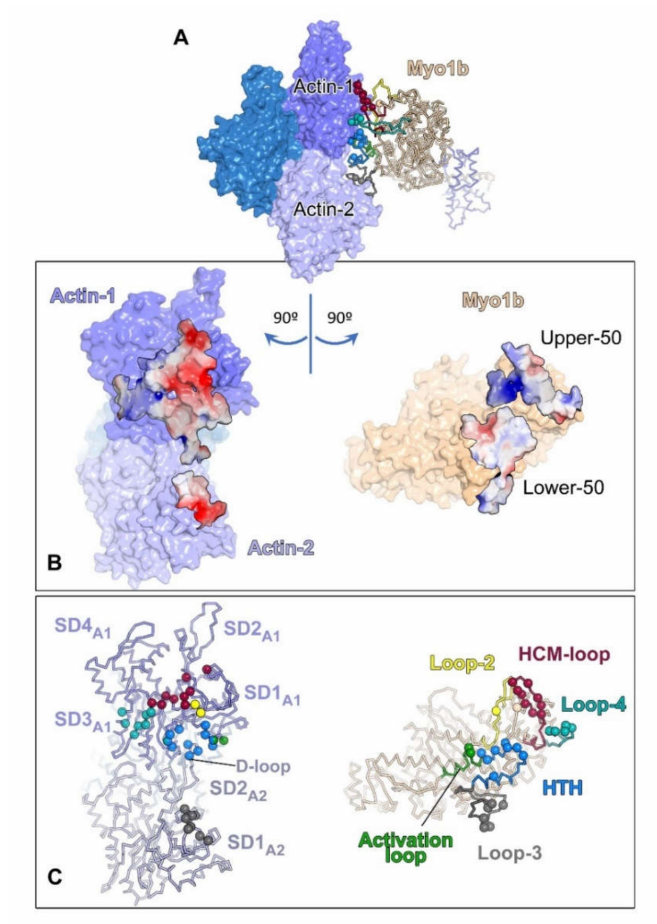
Figure 2. The actin–myosin interface. ( A ) The Myo1b motor domain bound to F-actin (with only 3 actin subunits). ( B ) Actin (left) and myosin (right) surfaces (within a 5 Å distance of each other) are colored according to the surface electrostatic potential distribution (red − 5; blue 5 KbT/ec). ( C ) Residues making inter-protein contacts (within 4 Å distance) are shown as balls. Right, the myosin actin-binding structural elements are shown in different colors. Left, actin residues are colored depending on the myosin structural elements that contact them. This figure was provided by Olena Pylypenko, UMR144/Institut Curie. The figure was made based on an experimental cryo-EM structure of Myo1B (PDB ID 6C1H) from (Mentes et al.